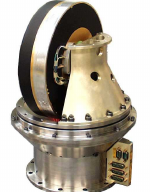
Figure 4: 15 Nms CMG actuator